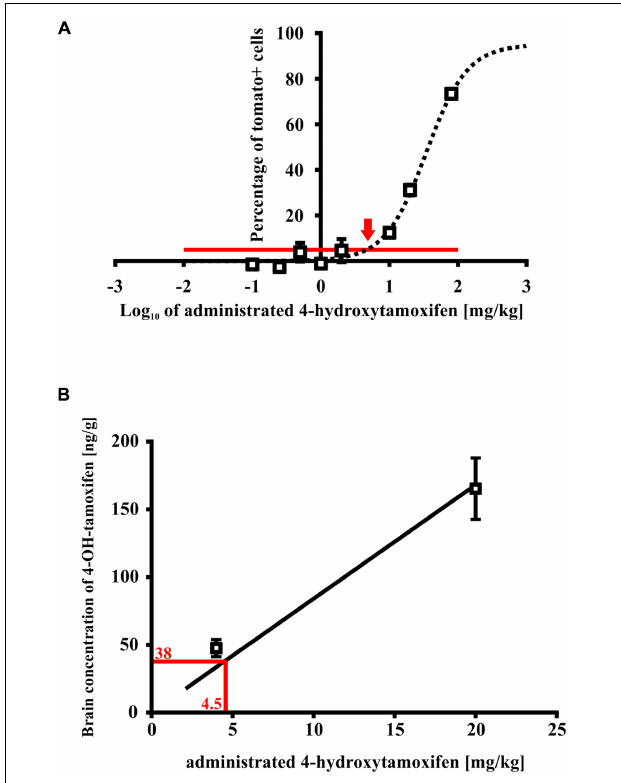
FIGURE 7 | Minimal effective 4-hydroxytamoxifen concentration in mouse brains. (A) Spontaneous recombination takes place in 3% of cells (indicated by the red line), relative to the maximal recombination rate. An additional recombination over the spontaneous level was caused by the administration of 4-hydroxytamoxifen in concentration exceeding 4.5 ± 1.3 mg/kg (indicated by the red arrow), (B) which corresponds to 4-hydroxytamoxifen concentration of 38.0 ± 22.0 ng/g in the